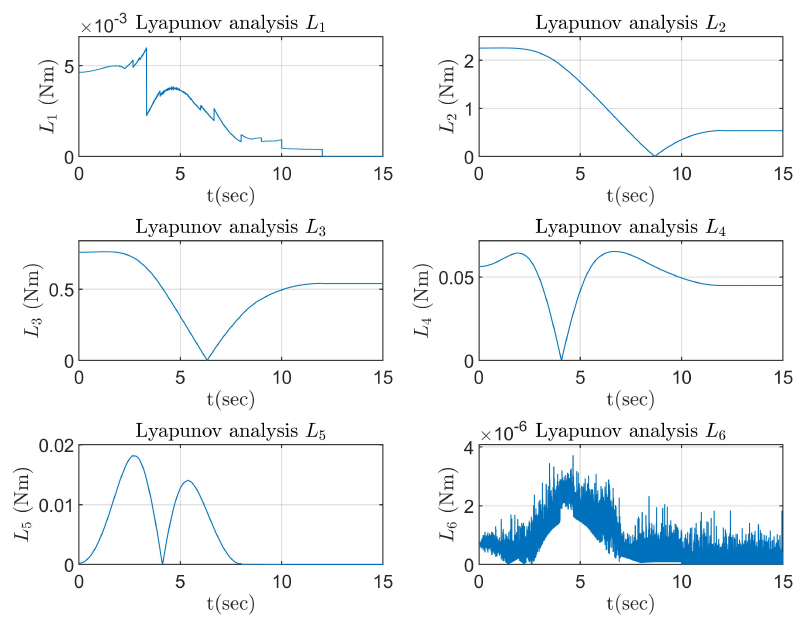
Figure 14. The signal of the Lyapunov analysis. Table 3. Comparison between the voltage that was needed to follow the trajectory and the voltage of the electronic